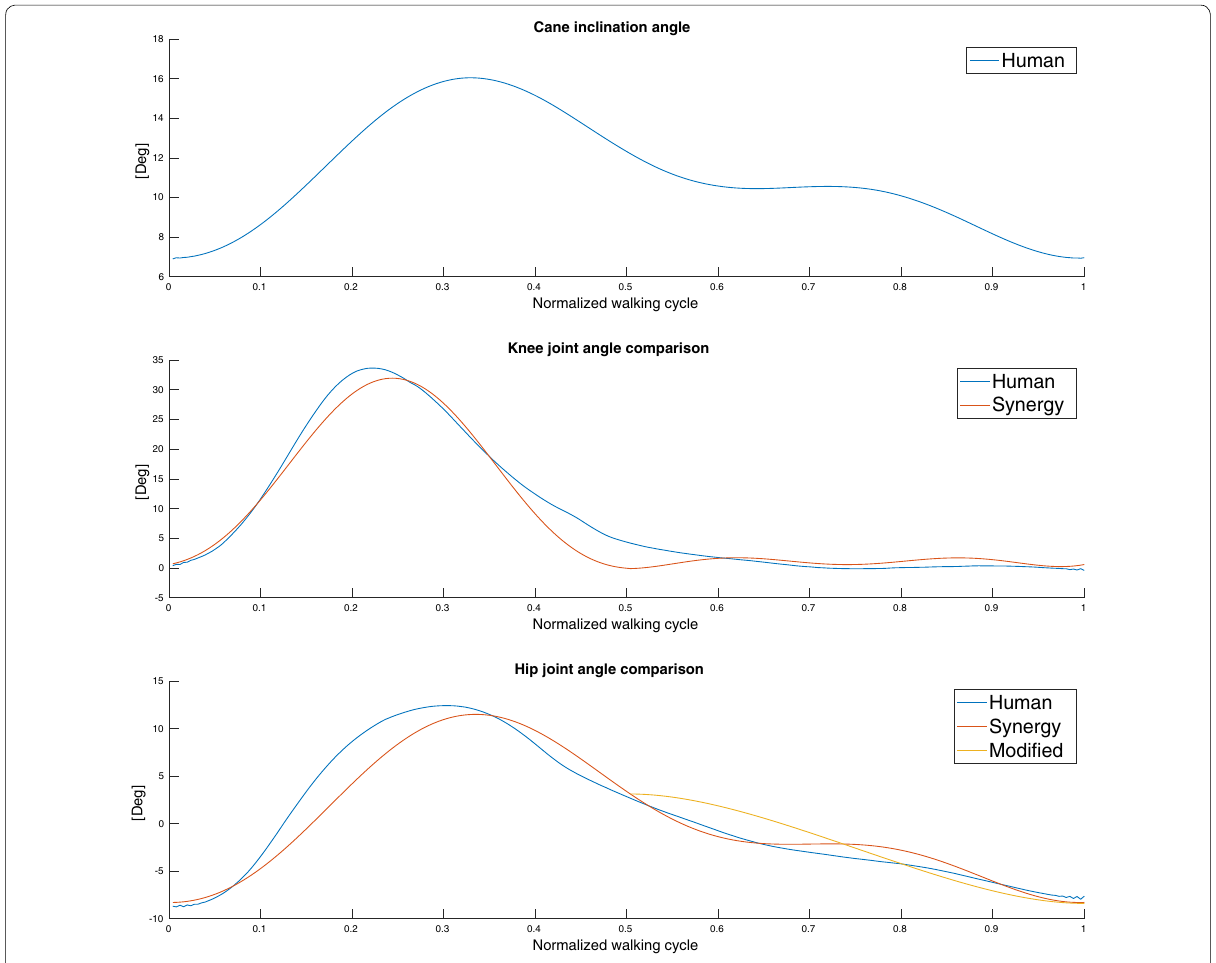
Fig. 9 Comparison of human gait, gait generated suing synergy and modified